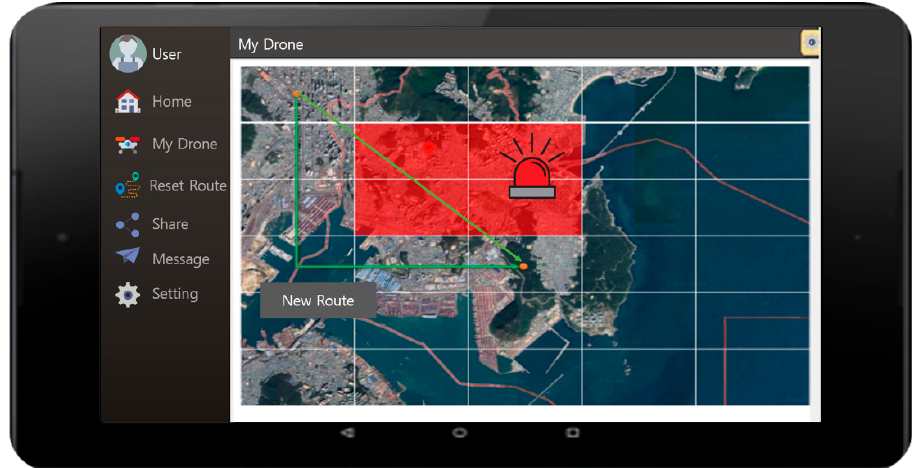
Figure 32. The lightning danger area and the recommended route (reset).